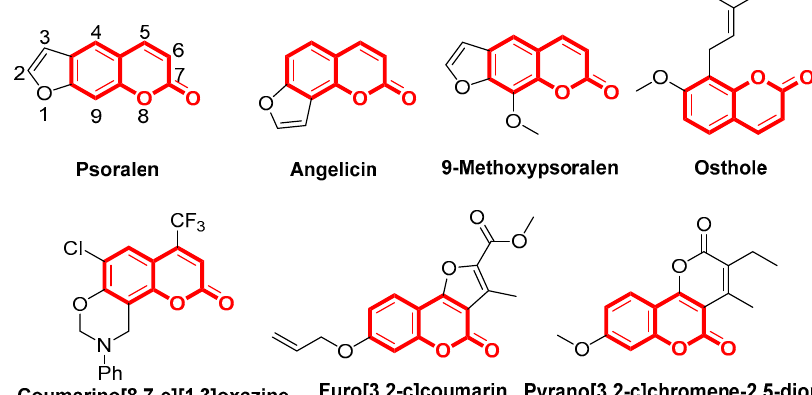
Figure 1. Structures of coumarin-containing compounds.